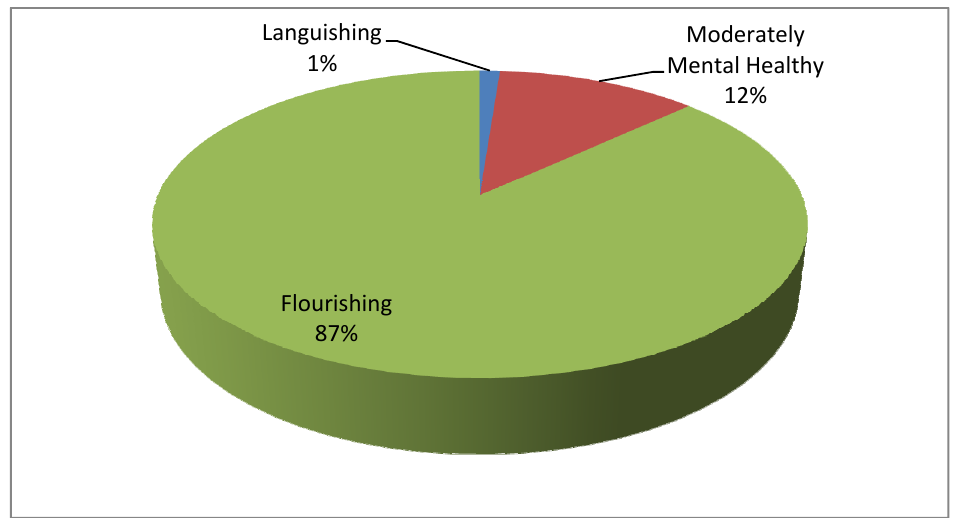
Figure 2. Distribution of the MHC-SF at Baseline (n = 83).